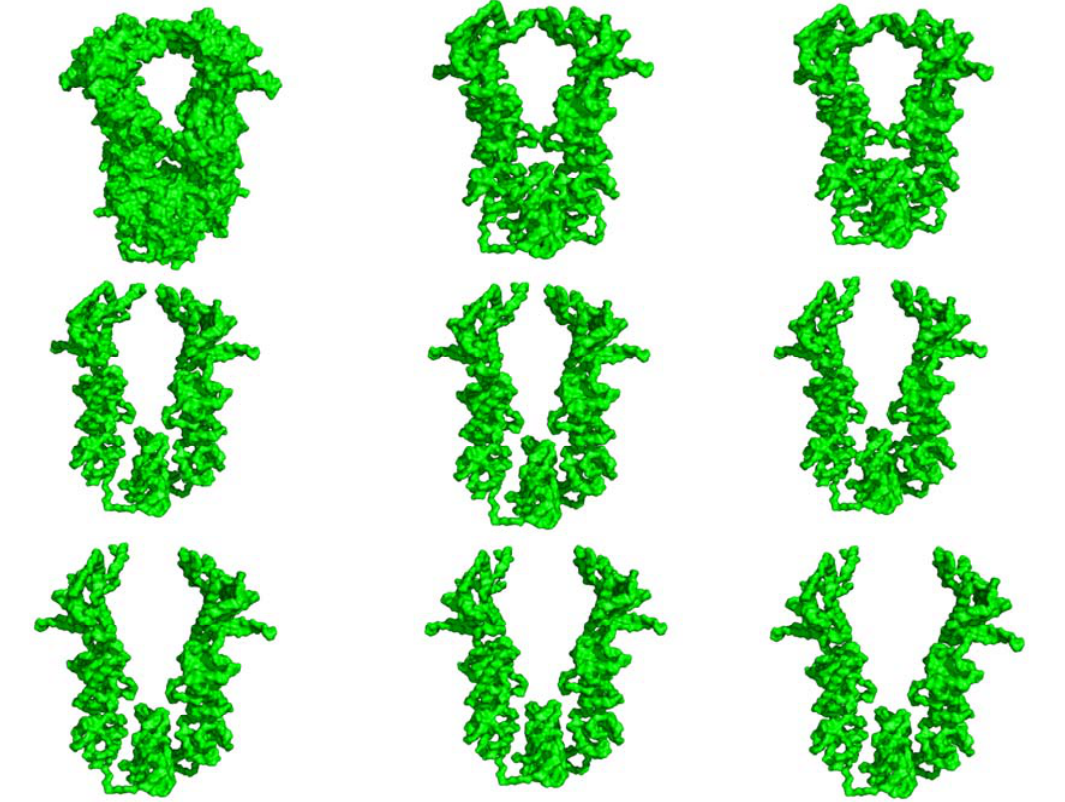
Figure 5. Conformational Ensemble of the Hsp90 Chaperone Employed in Docking